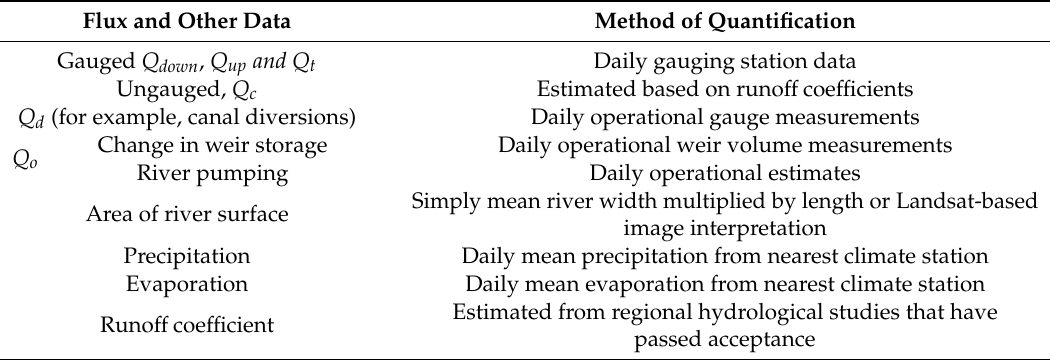
Table 1. Methods for quantifying water fluxes in the reach water balances.